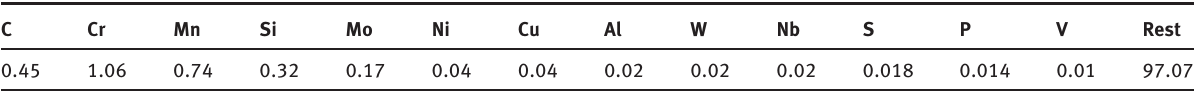
Table 1: Chemical composition of steel 42CrMo4 (mass%). (Designation: Steel name – EN/DIN: 42CrMo4 AISI 4140; Steel number (Mat. No; W. Nr.) – 1.7225)